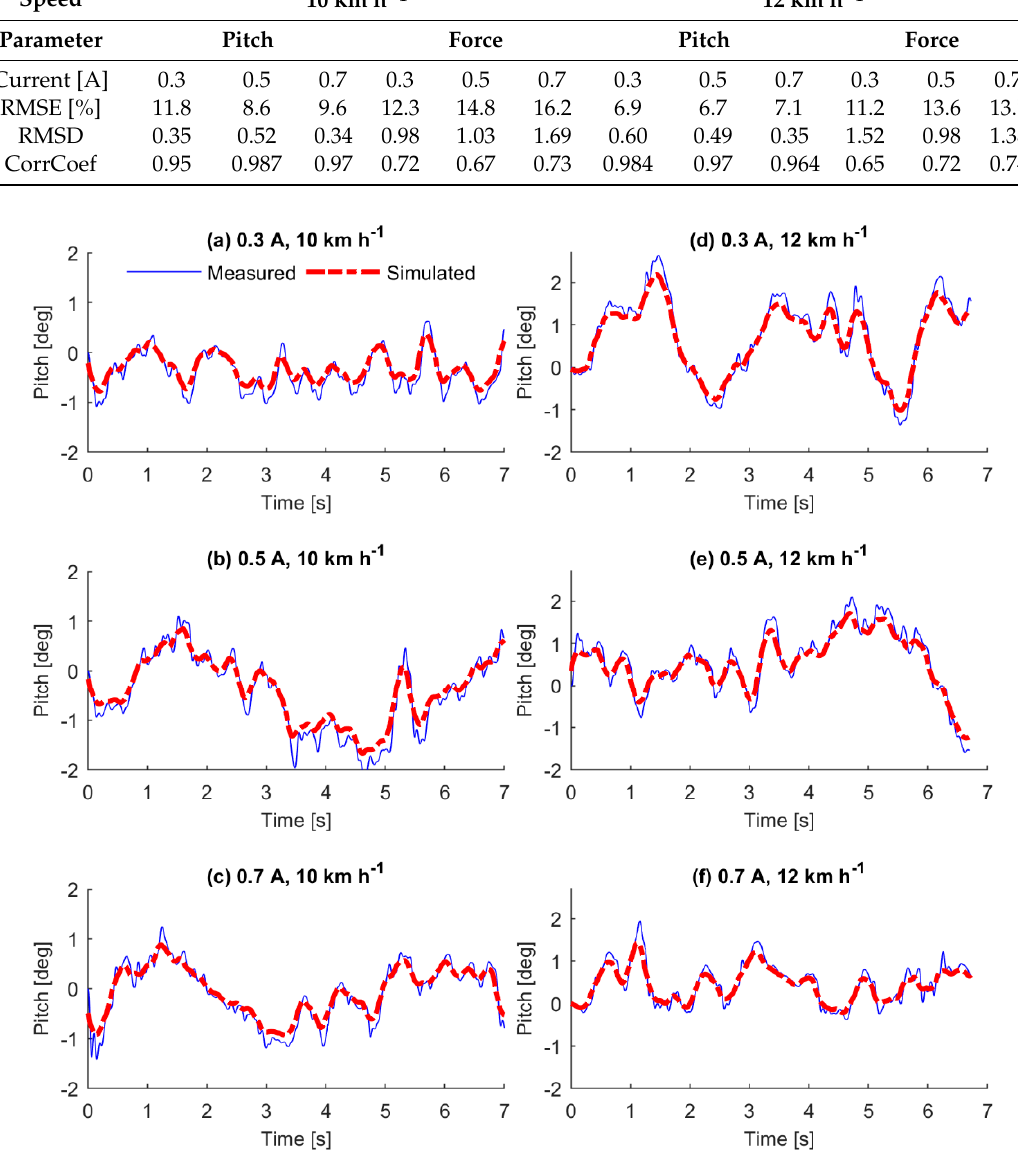
Figure 6. The measured and simulated pitch angle of the assembly movements at the speed of ( a – c